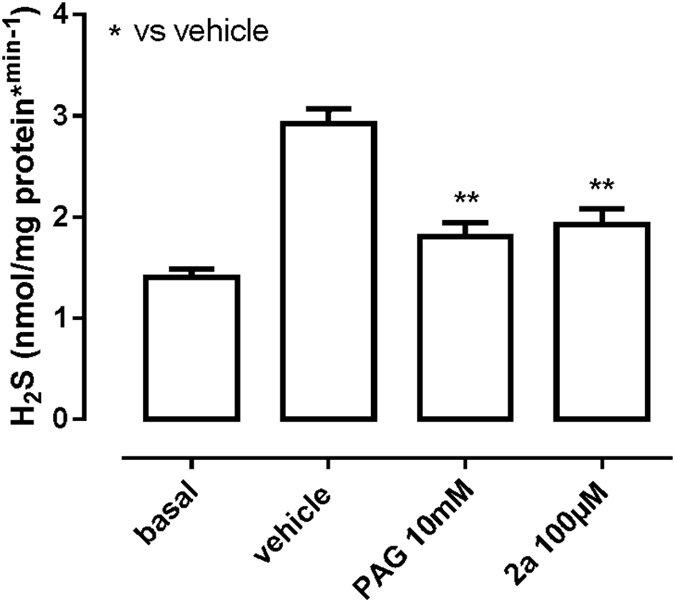
Comparison of the inhibition of compound 2a and PAG by assessment of H2S production in mouse aorta homogenates.The conditions for H2S determination were chosen according to previous protocols17. Homogenized aorta was incubated with different concentrations of compounds for 30 minutes and added to the reaction mixture. ZnAc (1%, 250 μL) was added to trap H2S followed by TCA (10%, 250 μL) and N,N-dimethyl-p-phenylenediamine-sulfate (20 μM, 133 μL). Absorbance was measured at a wavelength of 670 nm after 20 minutes. All samples were assayed in duplicate and compared to a calibration curve of NaHS. Basal values refers to H2S measurement in absence of L-Cys and it represents the endogenous production of H2S. Vehicle represents the used buffer, containing L-Cys.